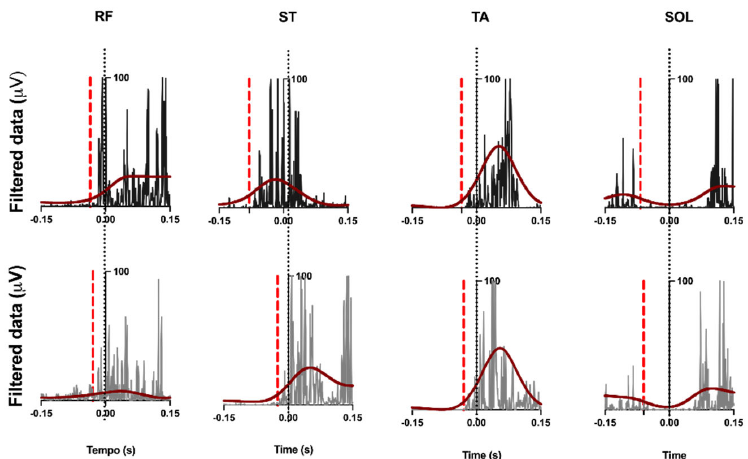
Figure 6. Data from control group (black) and infected group (gray). Rectified and filtered muscle activity at 6 Hz low pass of a typical participant in each group, recorded in a single trial. The solid vertical black line indicates the beginning of deltoid activity in the arm (T0), and the red dashed line indicates the beginning of activity of the evaluated muscles. Muscle abbreviations: ST, semitendinosus; RF, rectus femoris; SOL, soleus; TA, anterior tibial.